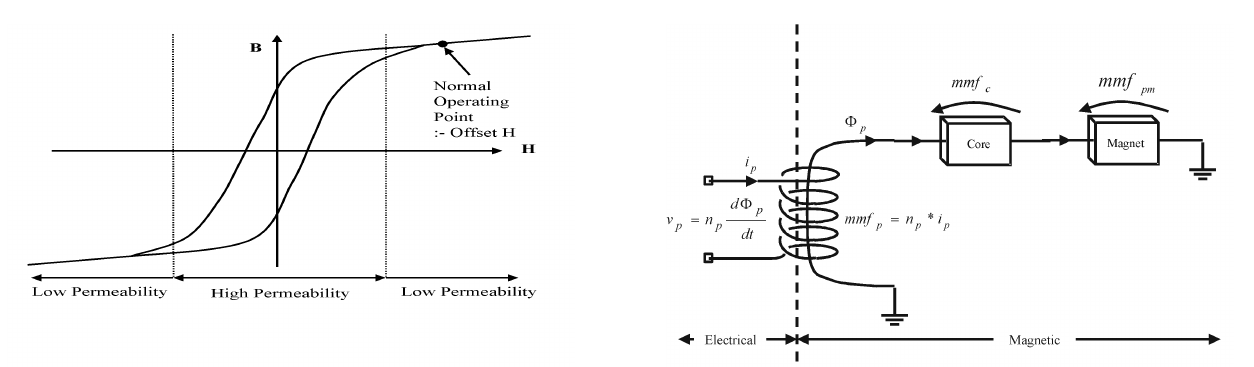
Figure 5: Linear Permanent Magnet